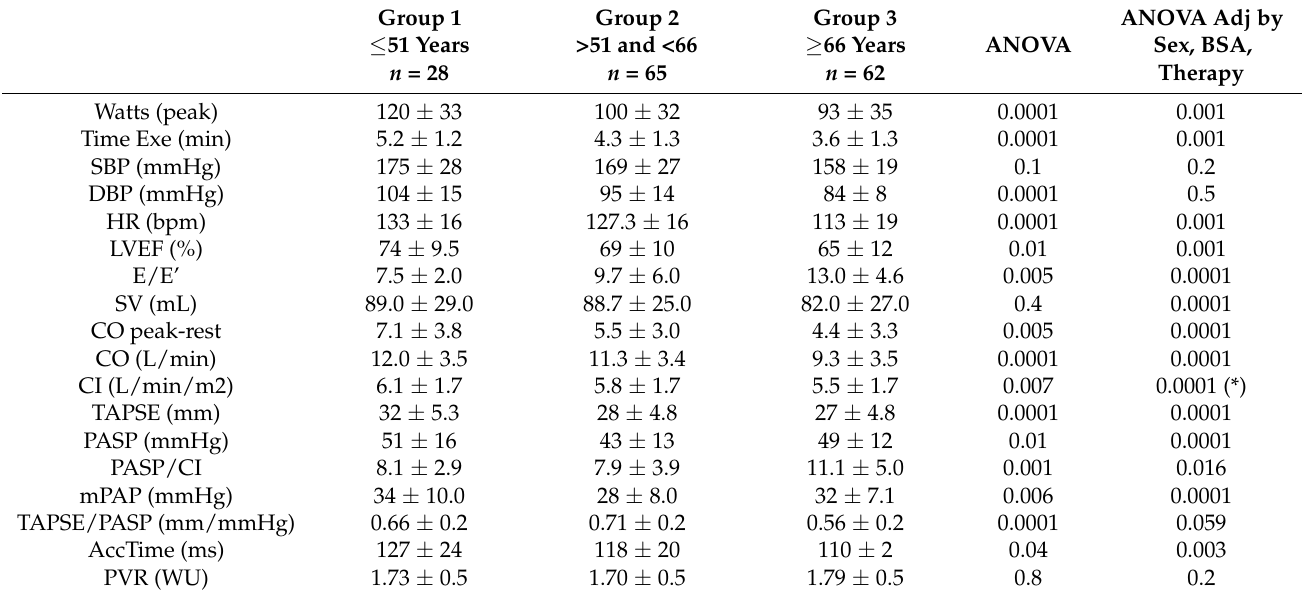
Table 6. Hypertensive patient characteristics at peak stress divided by age.